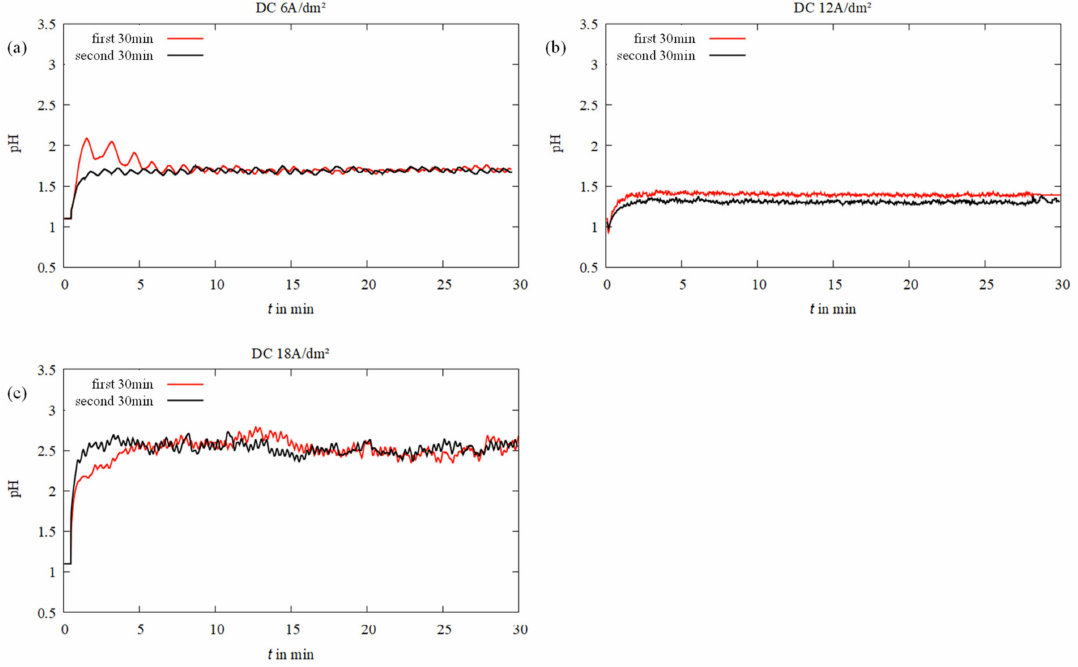
Figure 4. Near-surface pH in Fe-Cr-Ni electrolyte (fresh: first 30 min, used: second 30 min) over a period of 30 min for different DC densities. ( a ) depositions with DC 6 A/dm 2 ; ( b ) depositions with DC 12 A/dm 2 ; ( c ) depositions with DC 18 A/dm 2